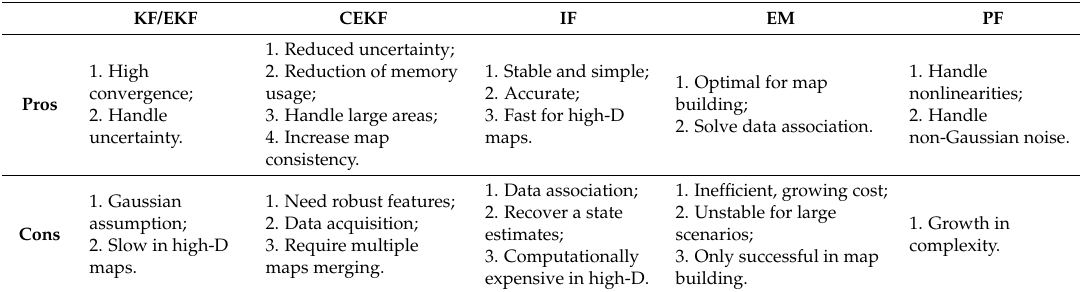
Table 1. List of pros and cons of filtering approaches applied to the SLAM framework. KF/EKF CEKF IF EM PF